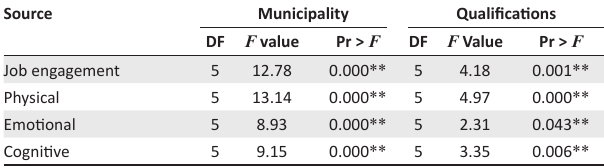
TABLE 2: Statistically mean differences of job engagement and